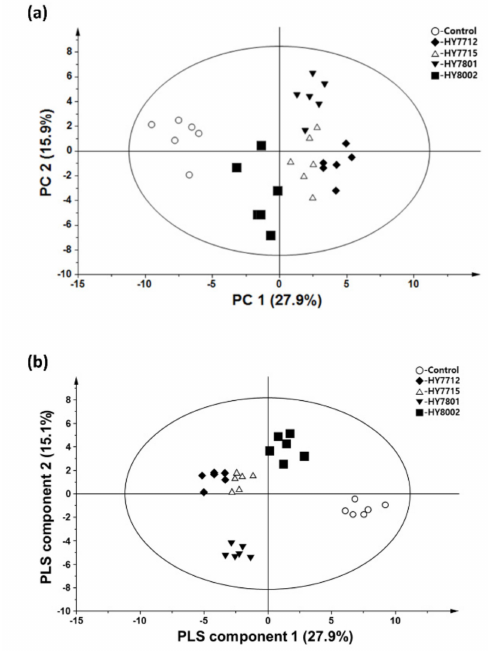
Figure 1. Metabolic and lipidomic data for the fermented and non-fermented VJs. ( a ) PCA score plot. ( b ) Partial least squares–discriminant analysis (PLS-DA) score plot. n = 6 in each